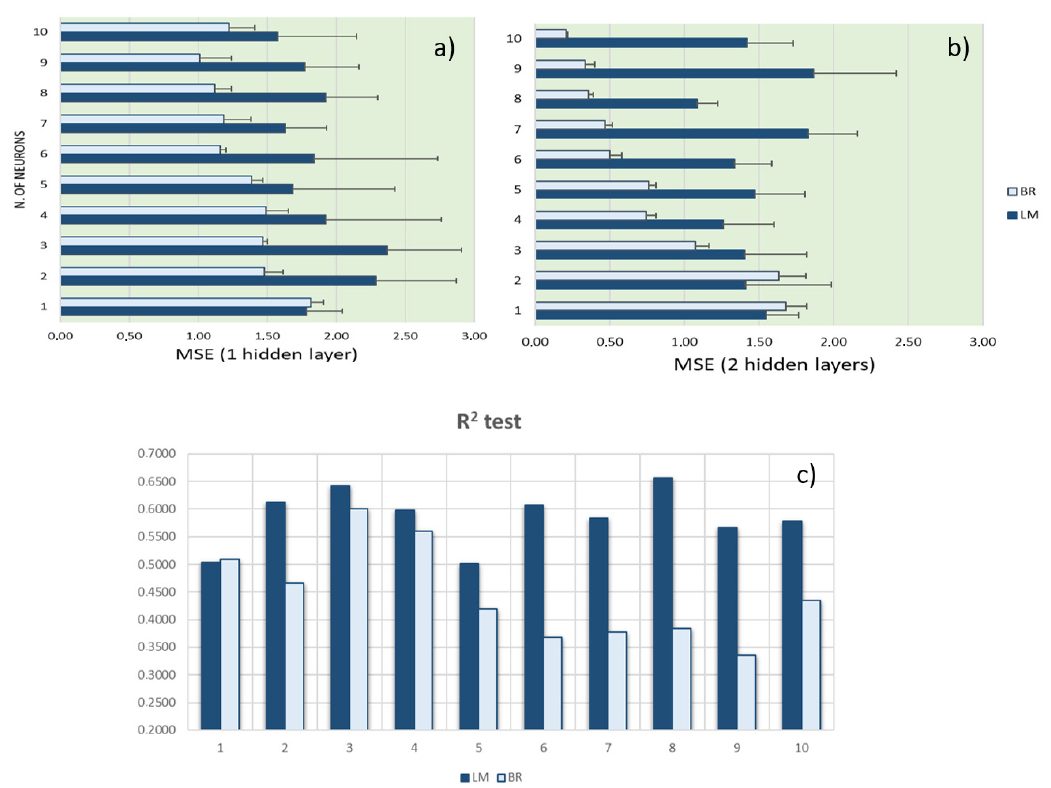
Figure 4. Mean square error (MSE) as a function of number of neurons for one hidden layer ( a ) and two hidden layers ( b ). R2 on only the test set comparing Levenberg–Marquardt and Bayesian regularization with different numbers of neurons for two hidden layers ( c ).